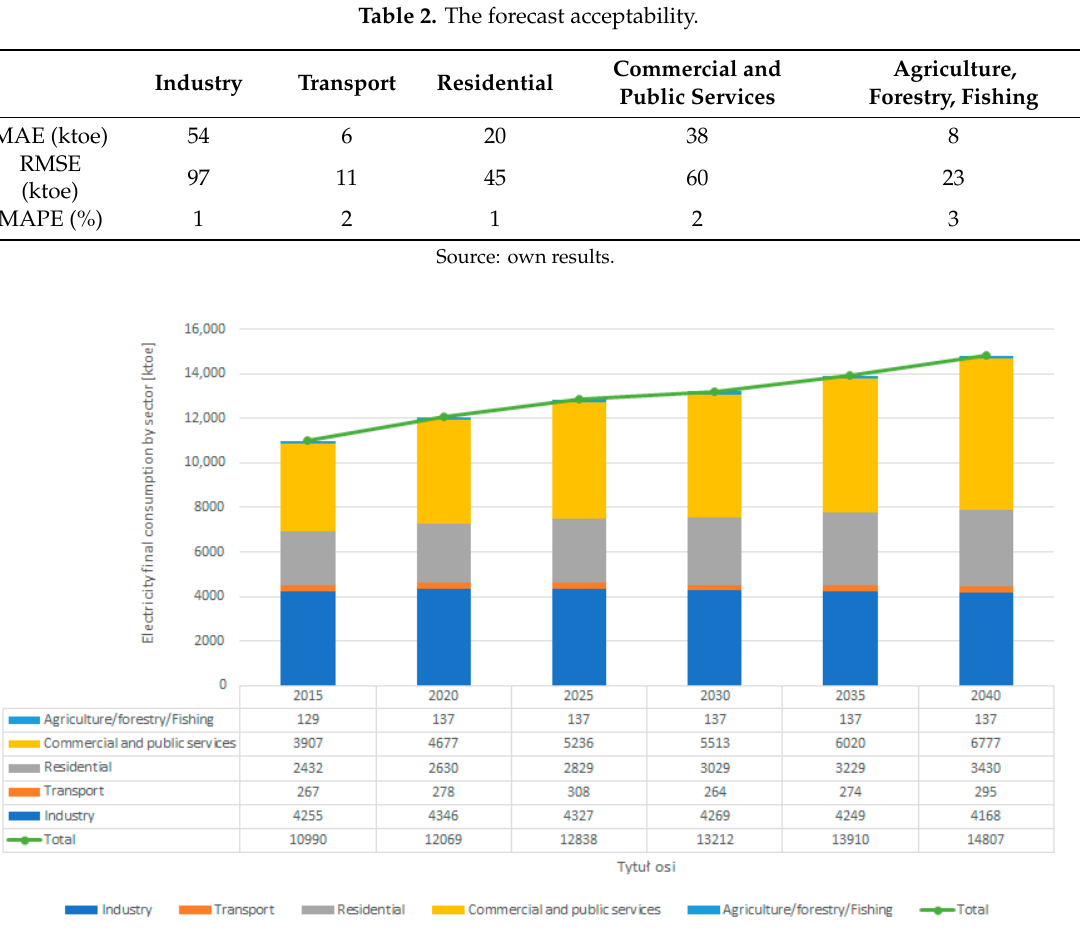
Figure 13. Forecast of final electricity consumption, ktoe, source: own study.